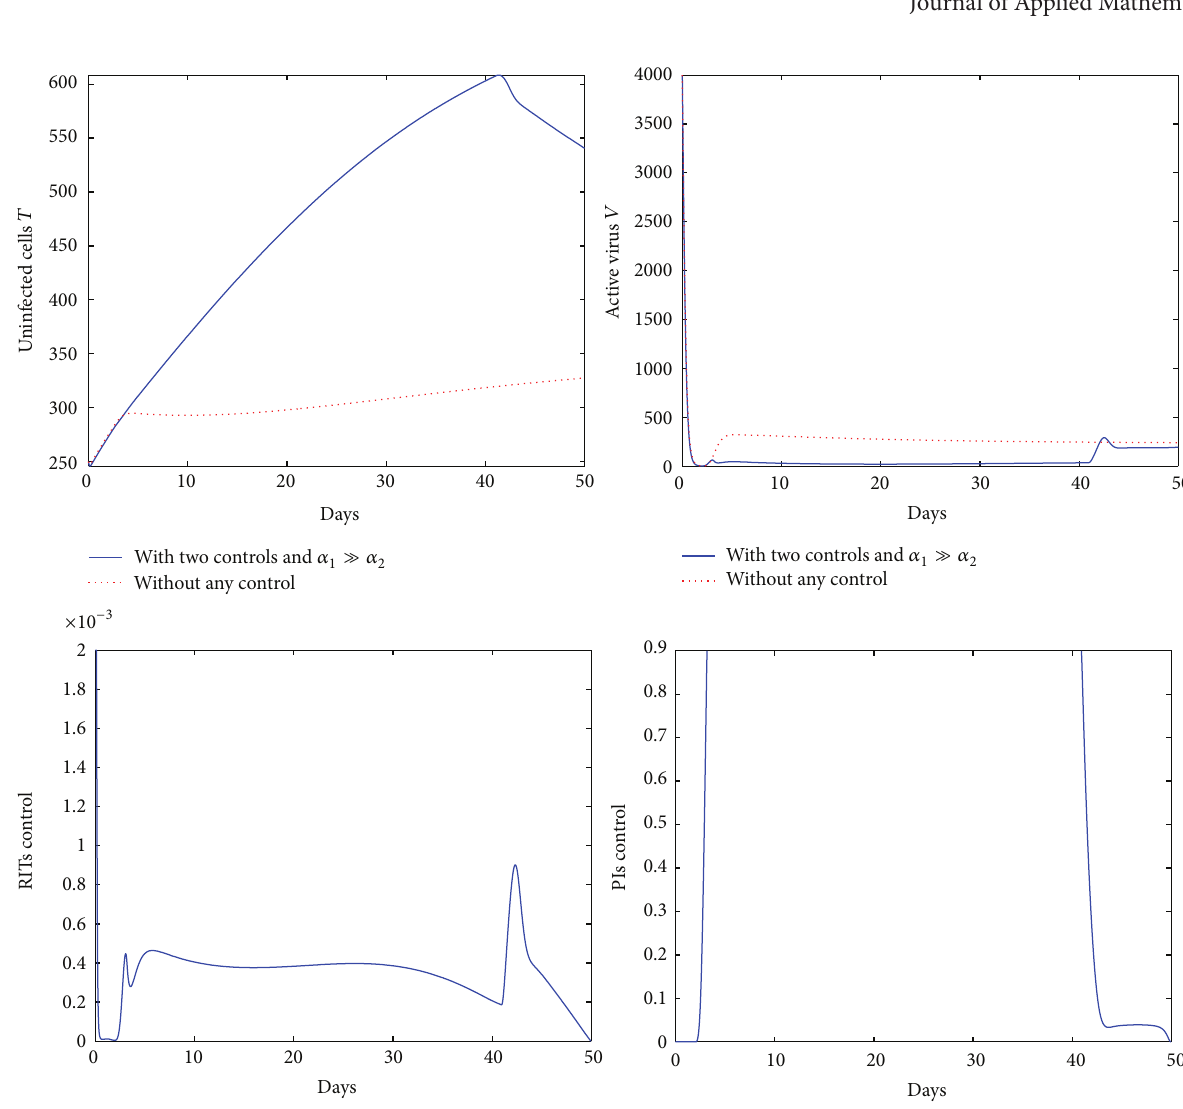
Figure 5: Optimal solutions using RTIs and PIs with 𝛼 1 ≫ 𝛼 2 for a 50-day